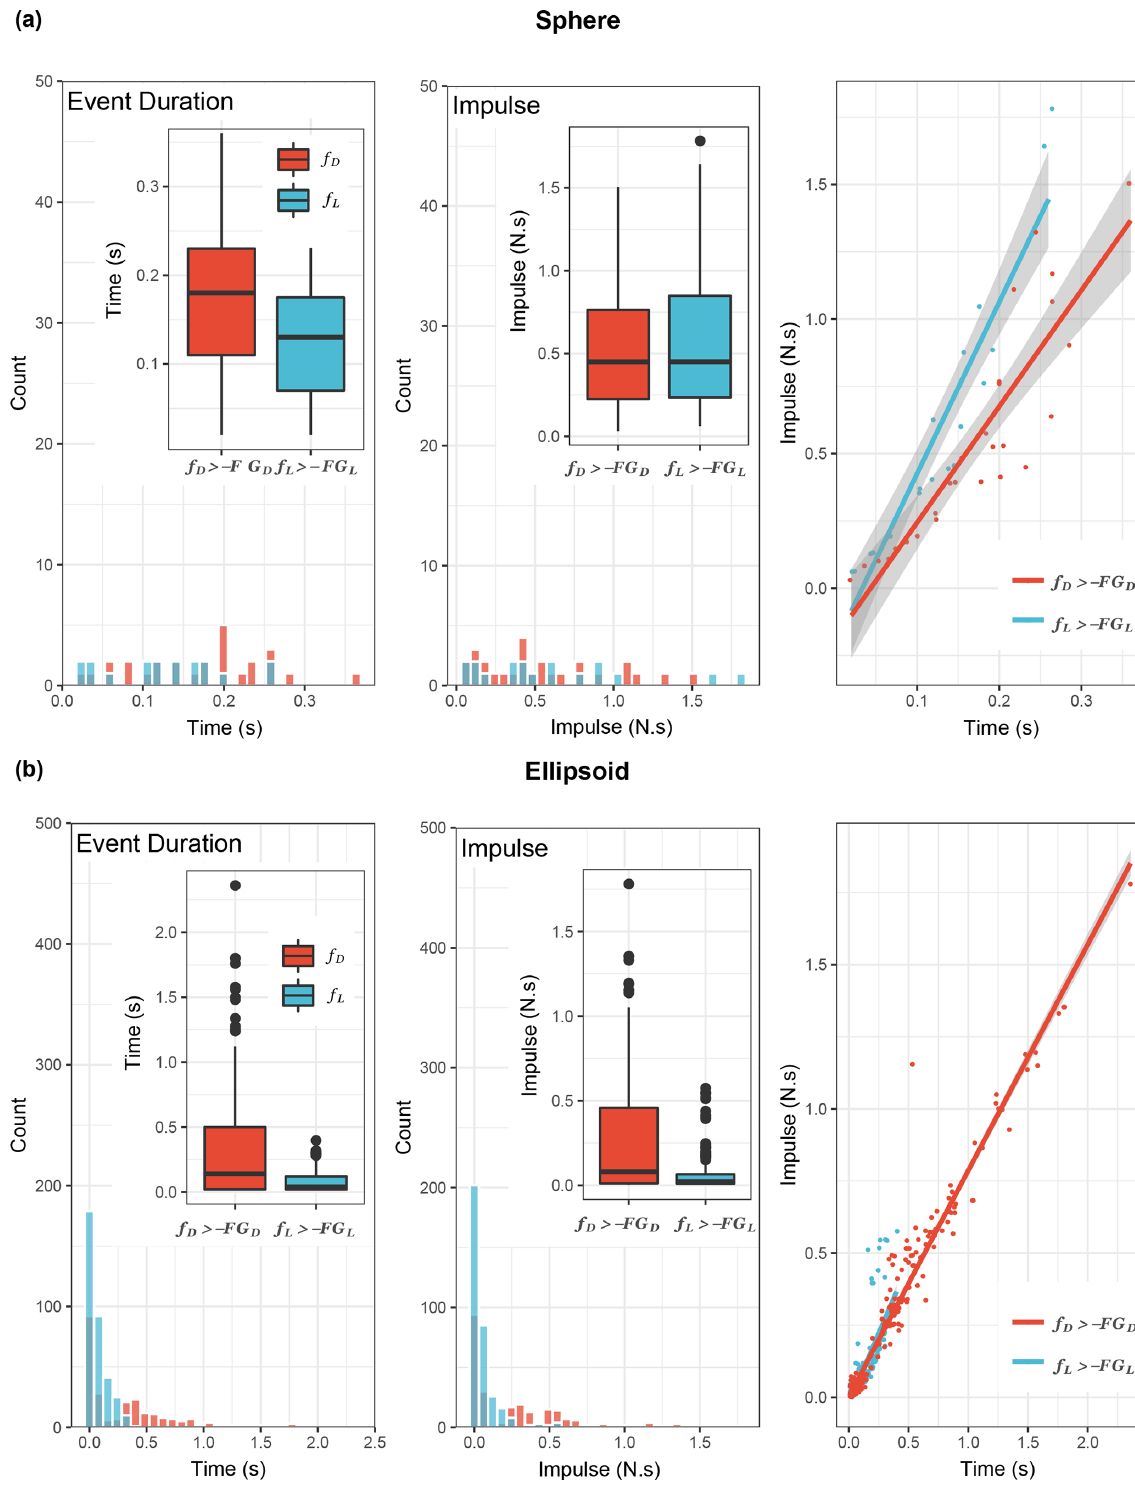
Figure 4. Inertial impulses and duration of threshold exceedance events for laboratory experiments. Impulses of all the inertial forces that exceeded the gravity forces. For the spherical particle (a) the drag impulse median (median of f D > − FG D events) is 0.01Ns − 1 higher than the lift impulse median (median of f L > − FG L events). For the ellipsoid (b) the equivalent difference is 0.013Ns − 1 . The relationship between the duration ( t ) and the impulse ( I ) during the exceedance events is linear for both the sphere and the ellipsoid (and for both f D > − FG D and f L > − FG L ) events. The entrainment of the ellipsoid is more dependent on short and low lift impulses than the sphere, demonstrating the effect of shape on the inertial